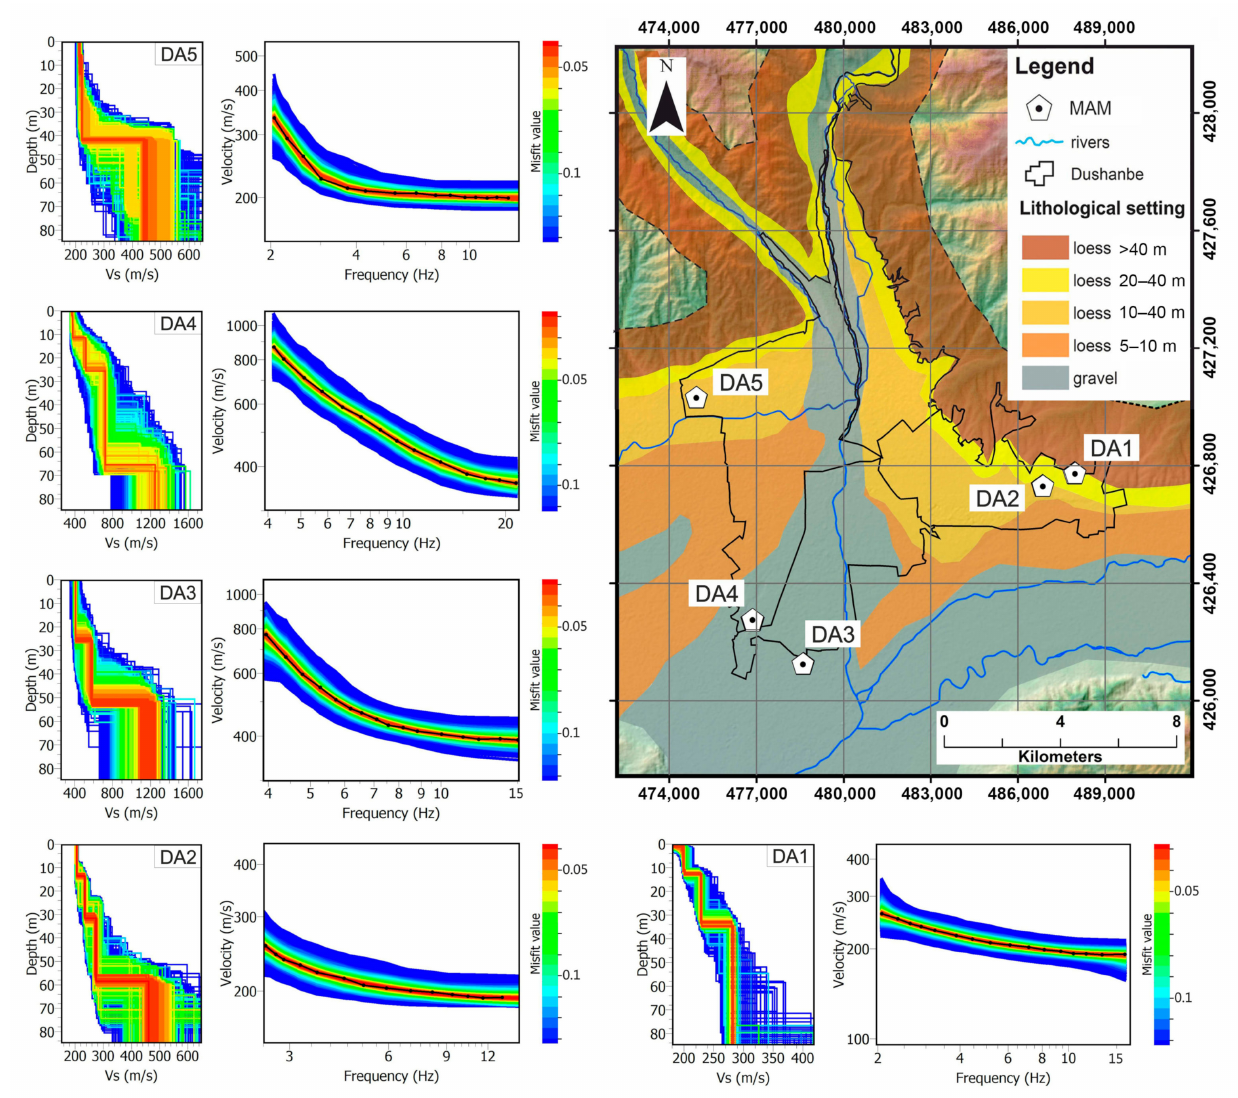
Figure 9. Inversion results of five microtremor array measurements (MAMs) and dispersion curves (black lines) and theoretical curves corresponding to the tested models (color indicates the misfit value). Shear-wave velocity models for each tested site. The best model achieved is highlighted in